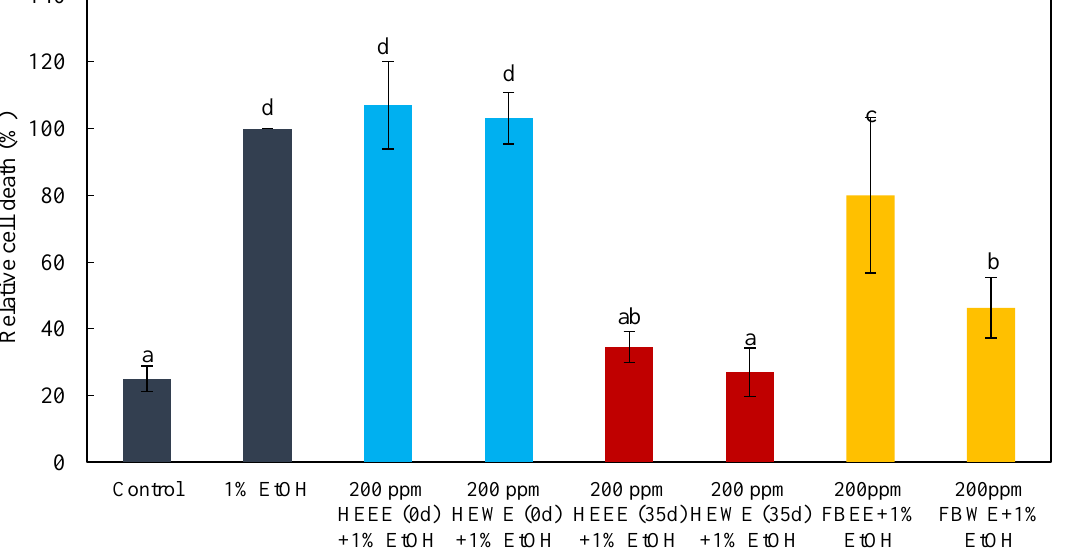
Figure 6. Effect of pretreatment with the hot water and ethanol extract of Hericium erinaceus solid-state fermented wheat product, fruiting body, and wheat on the brain cells of zebrafish embryos. The bar graphs represent the mean number of acridine orange-labeled cells, mean ± S.D.; n = 6 embryos. a–d The mean cell death values with different letters are significantly different ( p < 0.05).